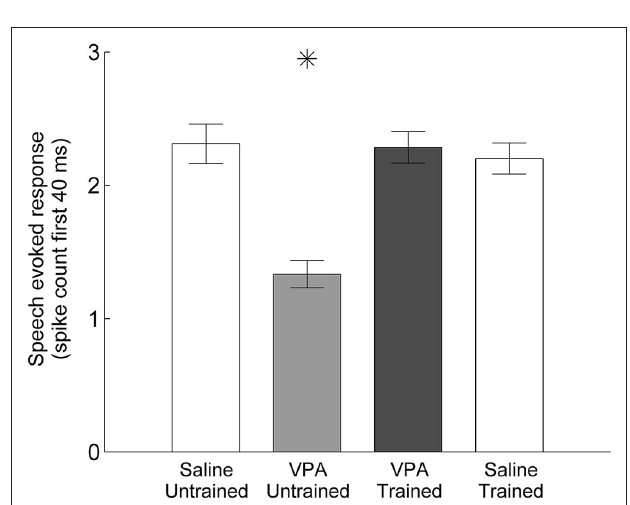
FIGURE 2 | Speech training enhances the neural response to the speech sound “gad” . The weakened response to “gad” in AAF in VPA untrained rats ( n = 11 rats; magenta line) is normalized in VPA speech trained rats ( n = 5 rats; green line), and is compared to